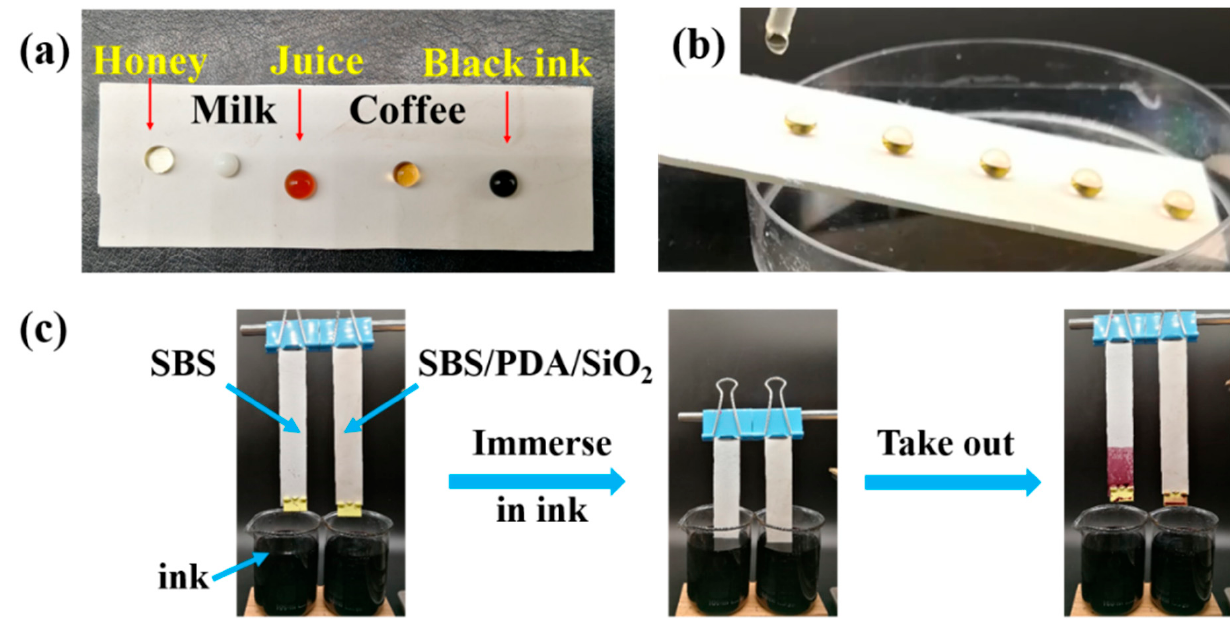
Figure 9. ( a ) Image of five kinds of droplets on the SBS/PDA/SiO 2 fibrous membrane surface. ( b ) Image of honey drops rolling off the SBS/PDA/SiO 2 fibrous membrane. ( c ) Images of the SBS fibrous membrane and the SBS/PDA/SiO 2 fibrous membrane that were immersed in ink and taken out.